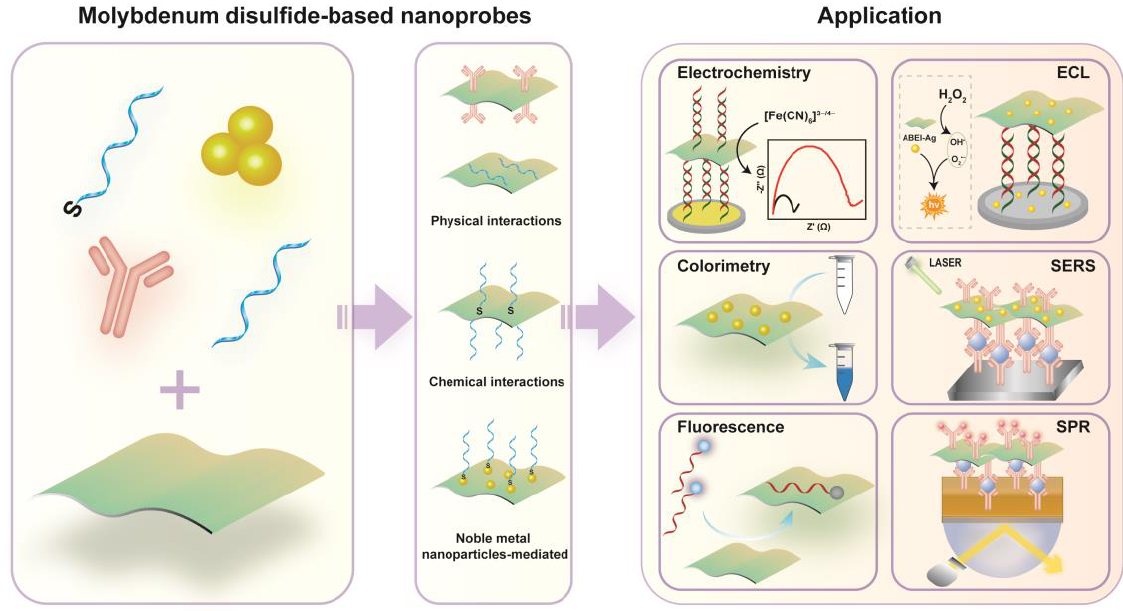
Figure 1. Schematic diagram of preparation and sensing application of molybdenum disulfide-based nanoprobe.